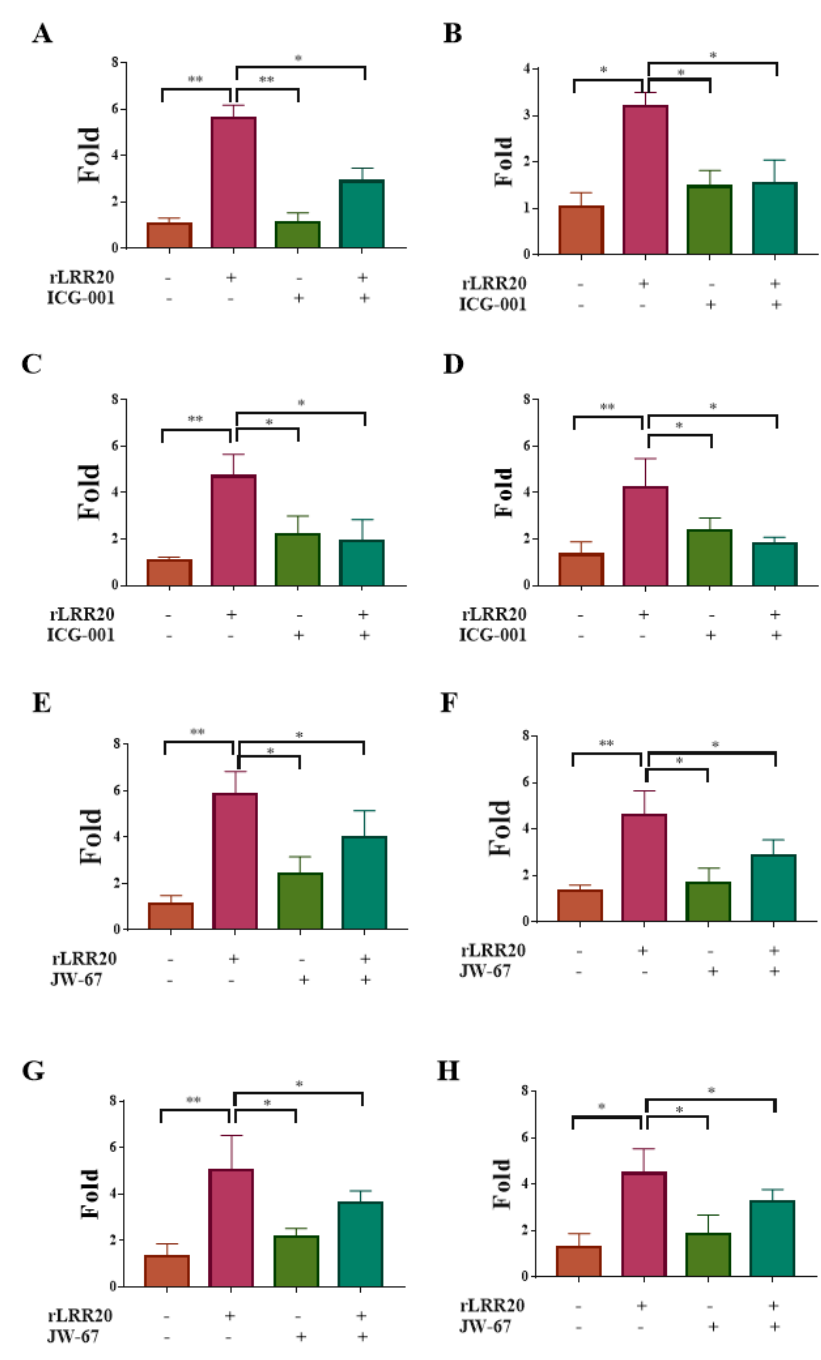
Figure 5. β -catenin inhibitors suppress rLRR20-induced MMP7 expression. Effect of the β -catenin inhibitors ICG-001 and JW-67 on rLRR20-induced MMP7 expression in HK2s and hRPTECs was examined. Effect of ICG-001 on the rLRR20-induced MMP-7 mRNA levels in HK2s ( A ) and hRPTECs ( B ). Effect of ICG-001 on the rLRR20-induced MMP7 protein levels in HK2s ( C ) and hRPTECs ( D ). Effect of JW-67 on the rLRR20-induced MMP7 mRNA levels in HK2s ( E ) and hRPTECs ( F ). Effect of JW-67 on the rLRR20-induced MMP7 protein levels in HK2s ( G ) and hRPTECs ( H ). ** p < 0.01; * p <